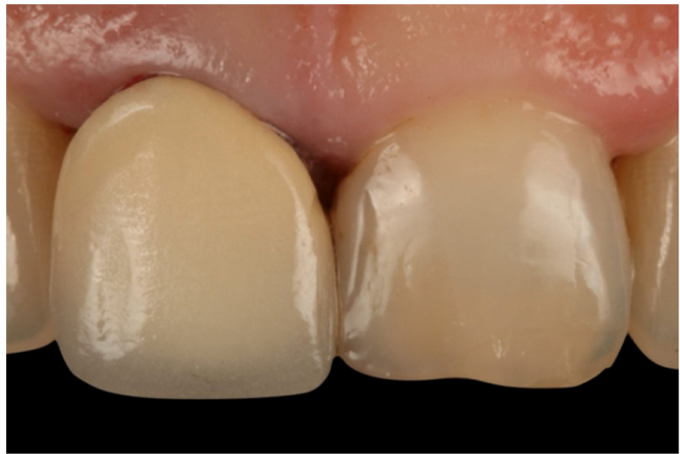
Figure 1. Initial photo of a patient included in the sample, with a full-coverage old